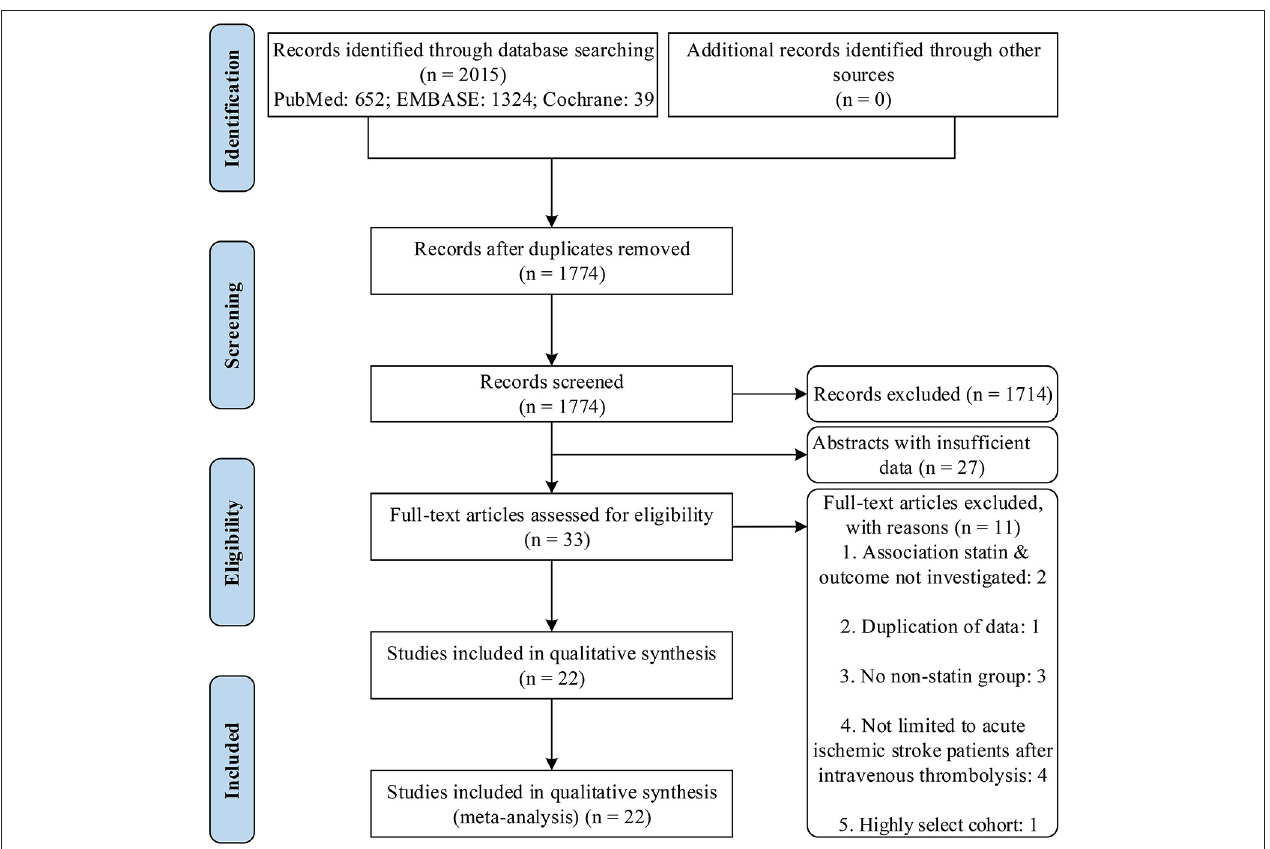
FIGURE 1 | PRISMA flow